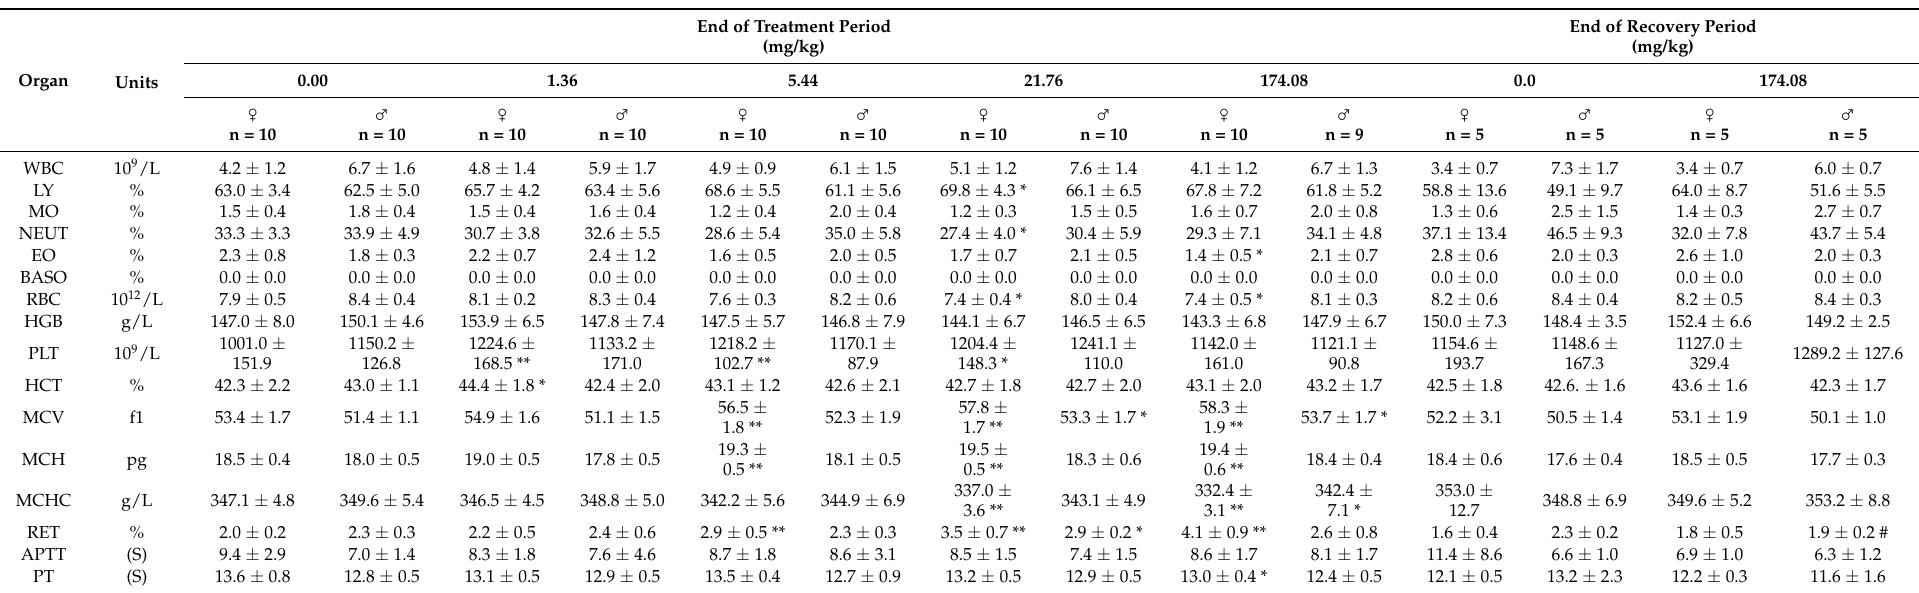
Table 1. Hematological values in SD rats orally administered AQ for 90